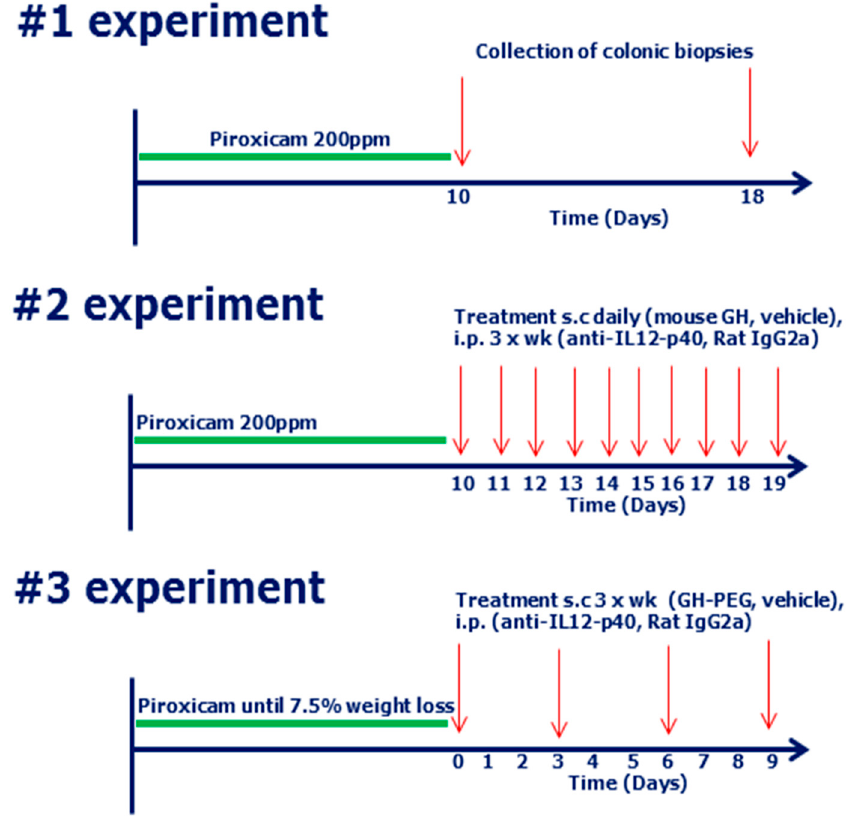
Figure 6. Graphical presentation of the in vivo protocols used in the study. Experiment 1 was used for gene expression profiling with arrows indicating euthanization of the animals (see Figure 4